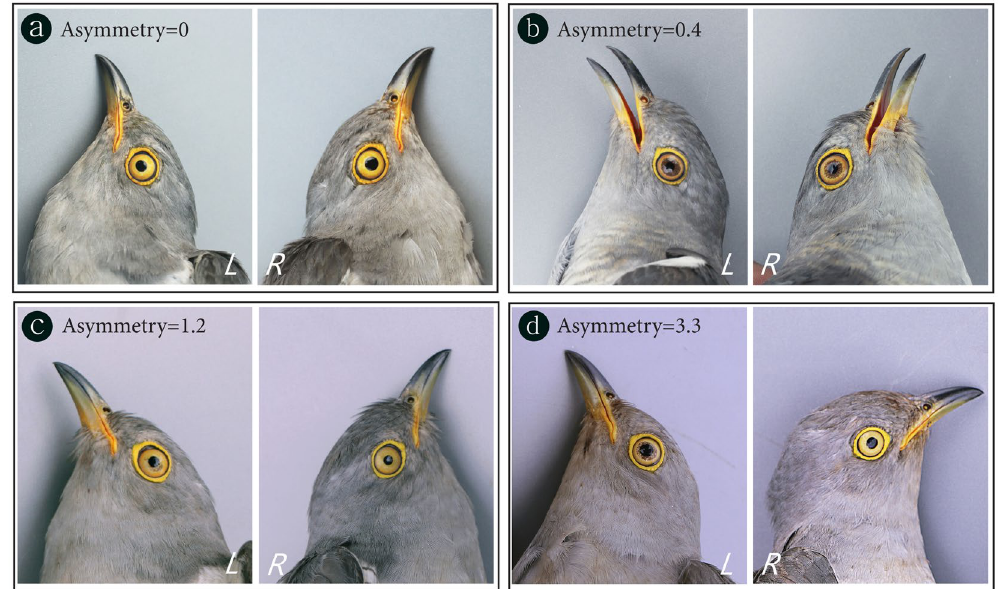
Figure 3. Photographs illustrating the variation of iris flecking asymmetry in the common cuckoo. Each set of photos shows the left and right side of the face of the same individual. ‘L’ and ‘R’ represent the left and right sides,